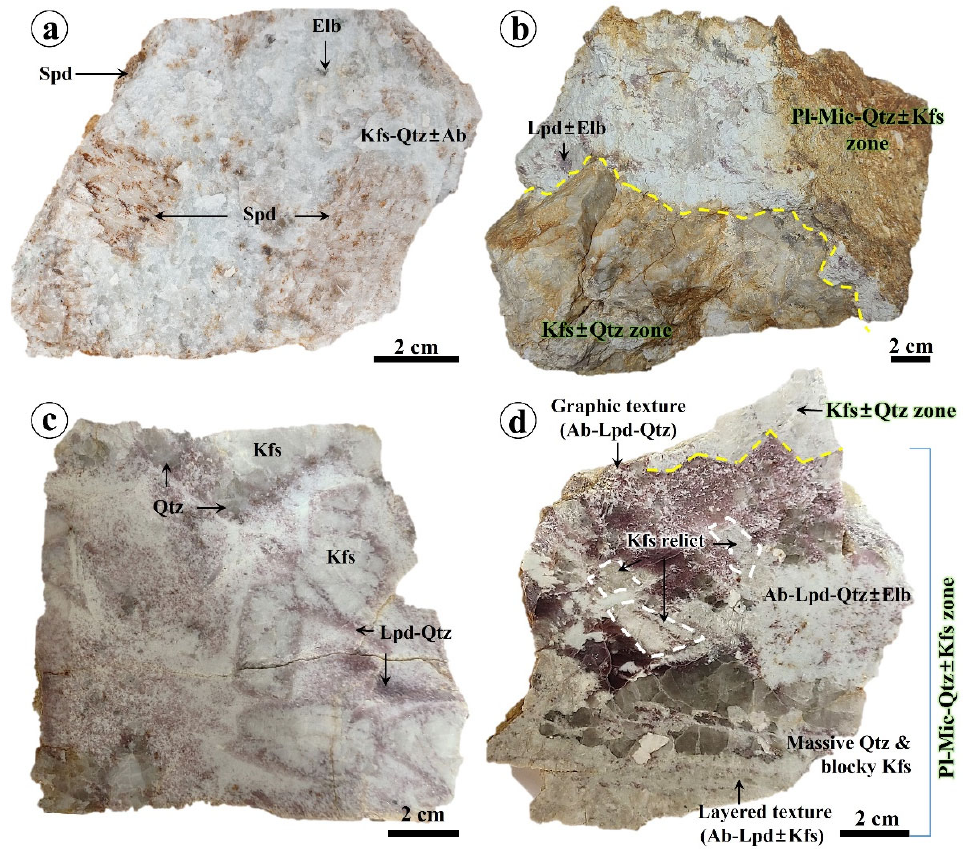
Figure 2. Representative rare ‐ element pegmatite (REP) rock samples from the Boam deposit. ( a ) Spodumene (light brown) and blocky K ‐ feldspar (milky white) in the western REP. ( b ) Internally zoned REP showing two distinct zones: a K ‐ feldspar ± quartz zone and a plagioclase ‐ mica ‐ quartz ± K ‐ feldspar zone. ( c ) Medium ‐ grained (<2.5 cm) blocky K ‐ feldspar surrounded by quartz ‐ lepidolite ‐ albite at the internal zone boundary. ( d ) Greisenized (hydrothermal altered) minerals showing pegmatite textures. Note the quartz ‐ lepidolite ‐ albite graphic and layered texture. Abbreviations: Ab = albite, Elb = elbaite, Kfs = K ‐ feldspar, Mic = mica, Lpd = lepidolite, Pl = plagioclase, Qtz = quartz, and Spd = spodumene.